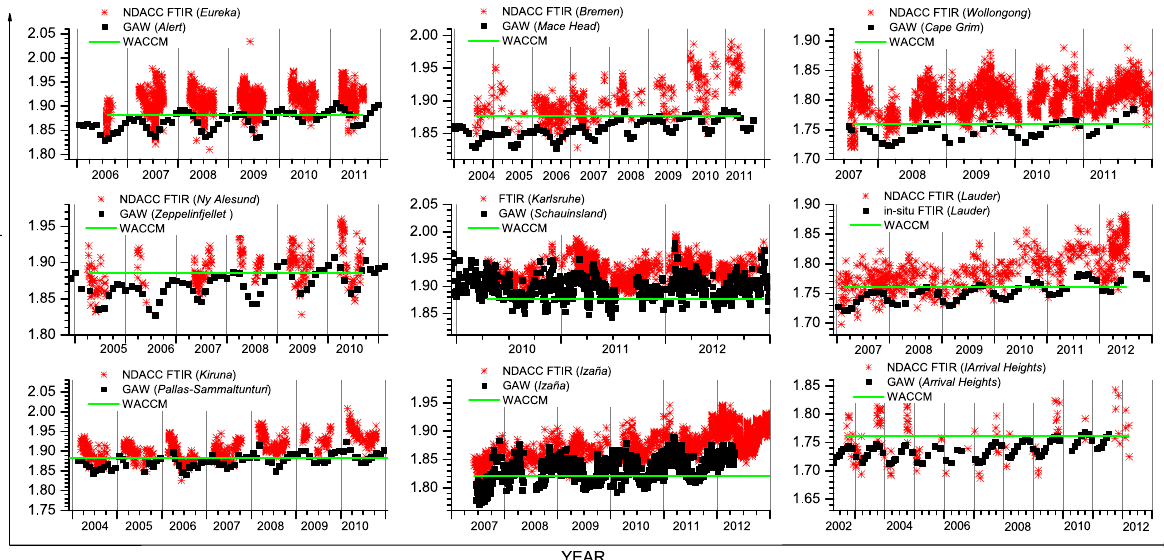
Figure 7. Tropospheric column-averaged CH 4 mole fraction measured by NDACC FTIR (red stars) and GAW in situ (black squares) at the nine different sites. Shown are all FTIR data and the GAW data that are representative for regional-scale signals (the filter methods are described in Sects. 3.2–3.10). These are daily data for Schauinsland and Izaña and monthly data for the rest of the GAW stations. The green line represents the WACCM a priori mole fraction applied for the NDACC FTIR